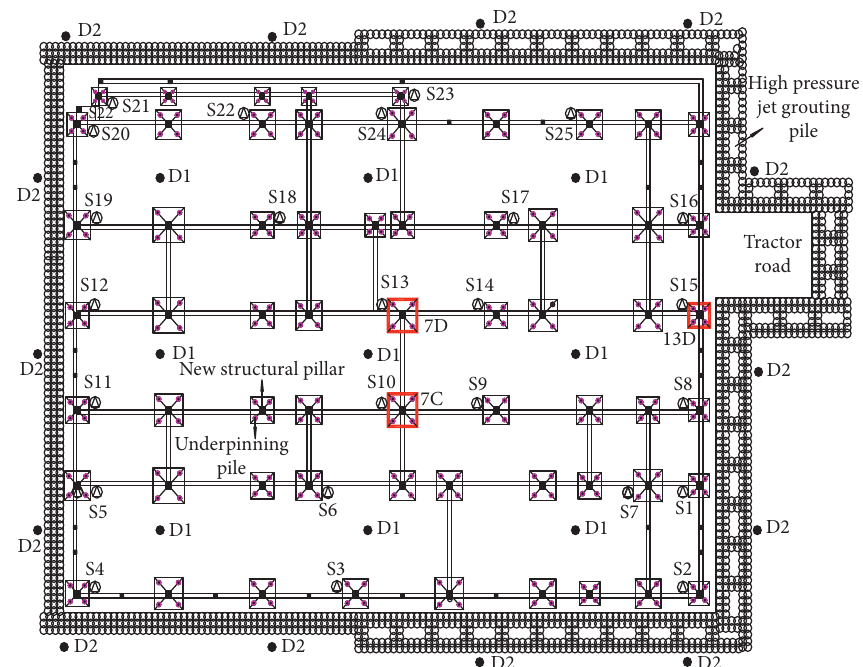
Figure 3: Plan of piles and monitoring points in No. 3 section basement construction project of Ganshuixiang. Note: (1) In the construction process, we monitored the piles and pillars at the caps of 7C, 7D, and 13D. (2) D1 and D2 are the dewatering well points. (3) S1–S25 are the subsidence monitoring